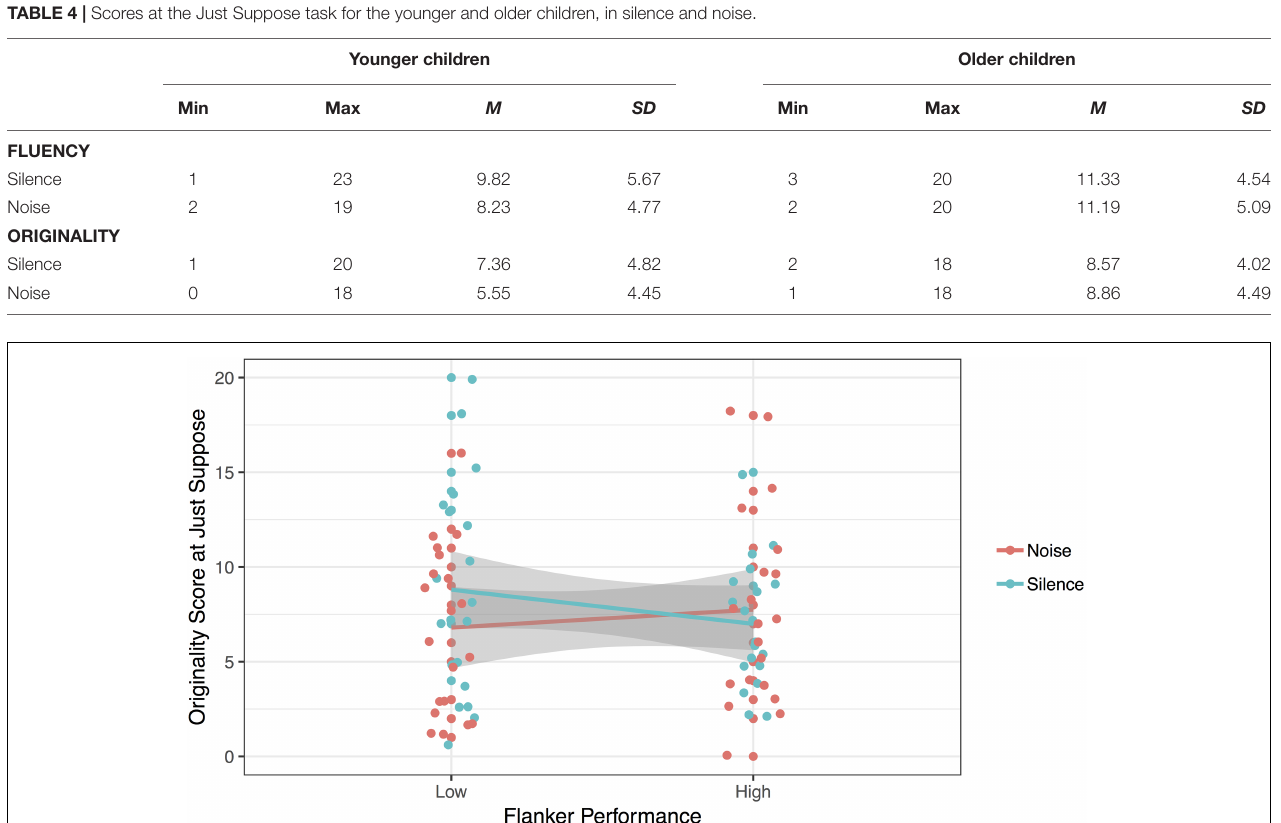
TABLE 4 | Scores at the Just Suppose task for the younger and older children, in silence and noise.